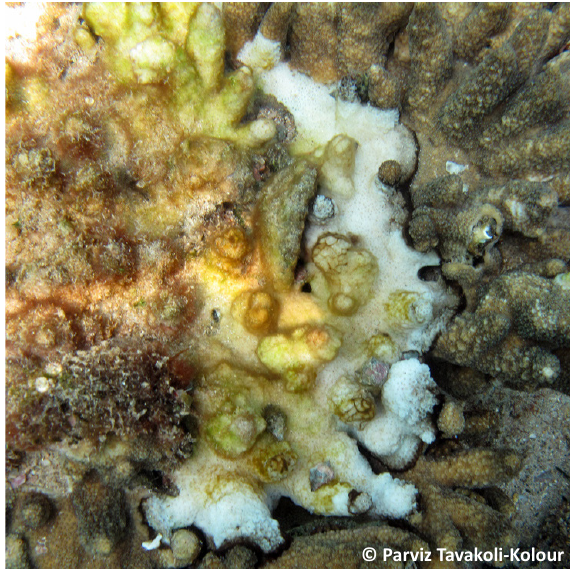
Image 1. Black band disease on Acropora